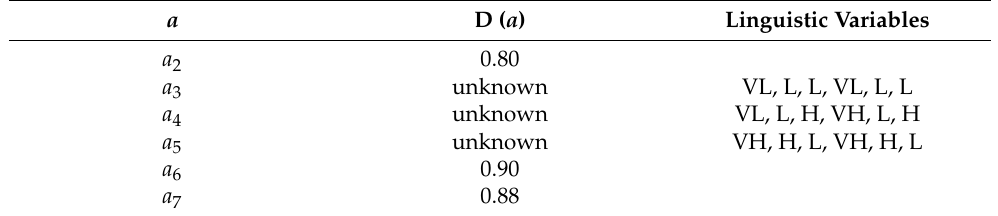
Table 8. State distributions in Figure 5.